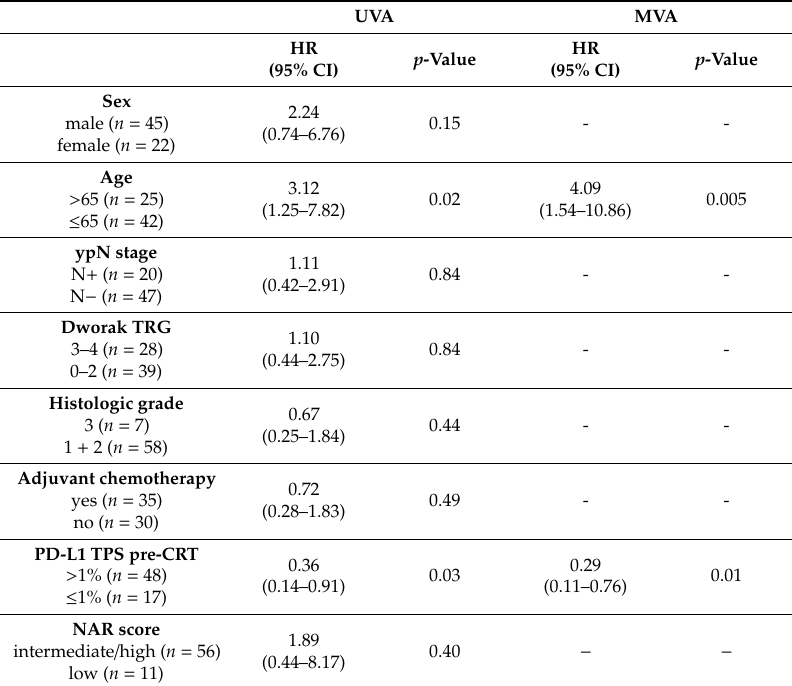
Table 3. Univariate and multivariate analysis for overall